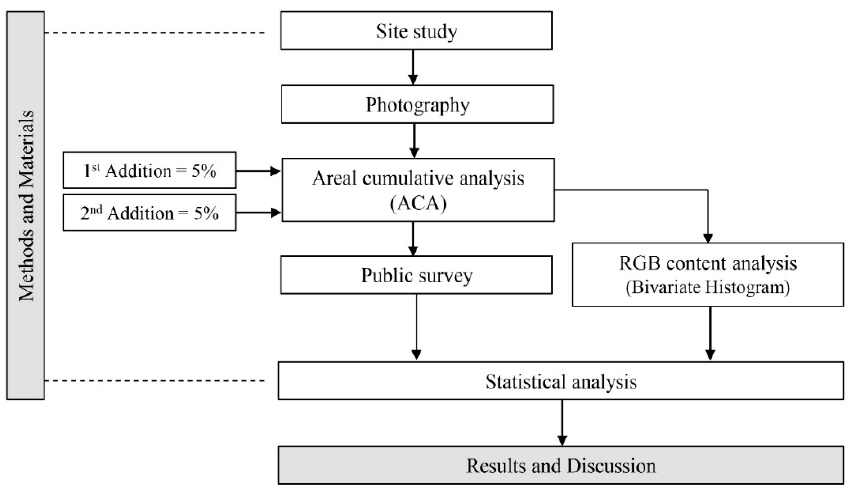
Figure 3. The methodological flowchart of the study.